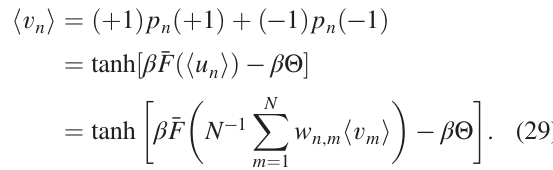
FIG. 4. Network convergence with effective threshold reduc- tion by nonlinear dendrites. Simulation of a network of N ¼ 100 binary neurons with Θ ¼ 0 . 4 , B ¼ 2 , P ¼ 8 , and Var ½ w (cid:1) ¼ 0 . 1 . Simulations are performed with identical initial states, topology, and identical realization of the (random) order of updates. The energy function [Eq. (15)] for linear input summation (solid black line) decreases, and the network converges toward a fixed point. Including weakly nonlinear branches (thick gray line, θ ¼ 0 . 6 and D ¼ 1 ) does not alter the dynamics or the energy of the modified network [which is now given by Eq. (27)]. The unaltered dynamics is confirmed by the vanishing Hamming P N v − v 0 distance d ¼ 1 n j (dashed gray line) between the n n ¼ 1 j 2 N two systems. For stronger dendritic spikes (solid red line, θ ¼ 0 . 1 and D ¼ 2 ), deviations of the somatic input from its ensemble ¯ F average and slightly asymmetric couplings lead to occasional increases in the energy (red square), but network convergence is preserved (checked for 1000 runs). The dynamics converges toward an attractor that is different from that of the linear network, as shown by the Hamming distance (dashed red line) between the systems. When inhibitory and excitatory inputs are processed separately by the soma and the dendrites, respectively, no energy function is known, and we exemplarily choose the energy function given by Eq. (27) with ϑ ¼ Θ . The energy is then nonmonotonic (solid orange line, θ ¼ 0 . 1 and D ¼ 2 ), but the system nonetheless reaches a stationary state (checked in sim- ulations up to t ¼ 2000 ) that is different from the one of the linear system; cf. the Hamming distance (dashed orange